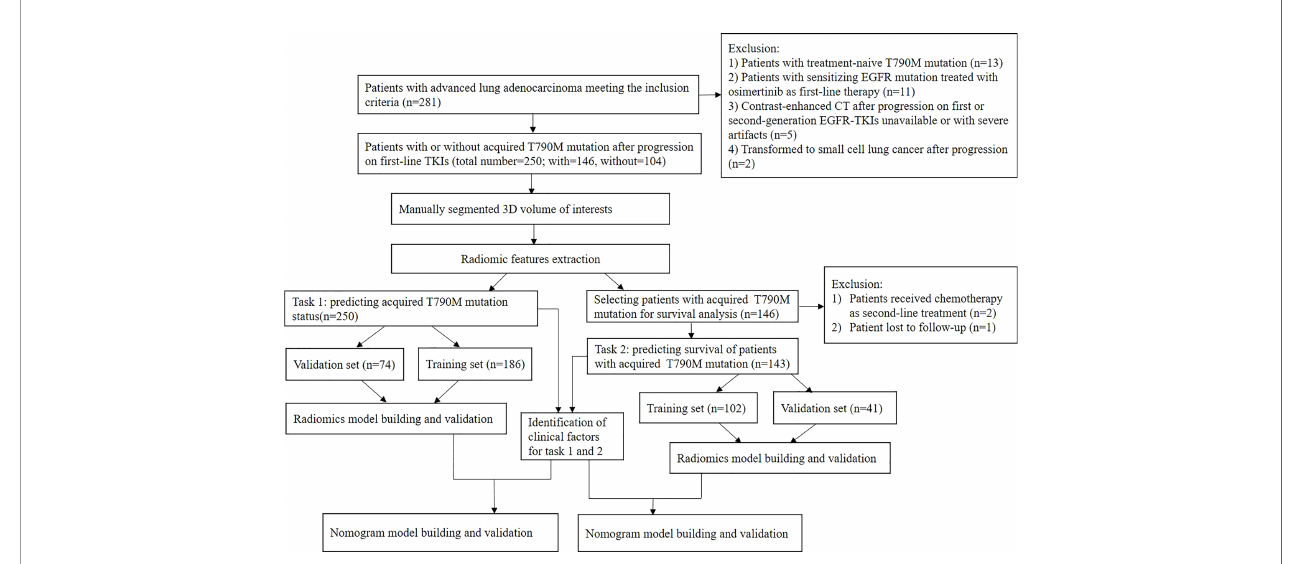
FIGURE 1 | Flowchart of the